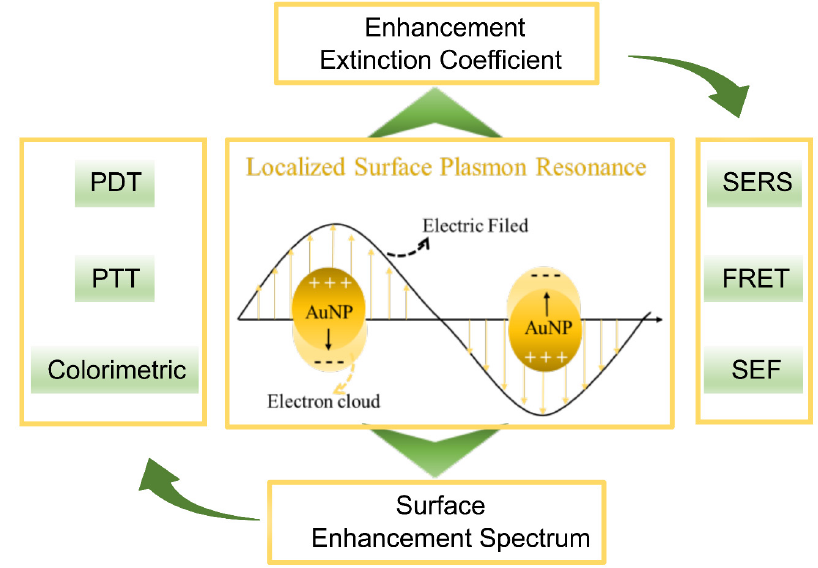
Figure 2. Localized surface plasmon resonance (LSPR) of AuNPs and associated properties. 110